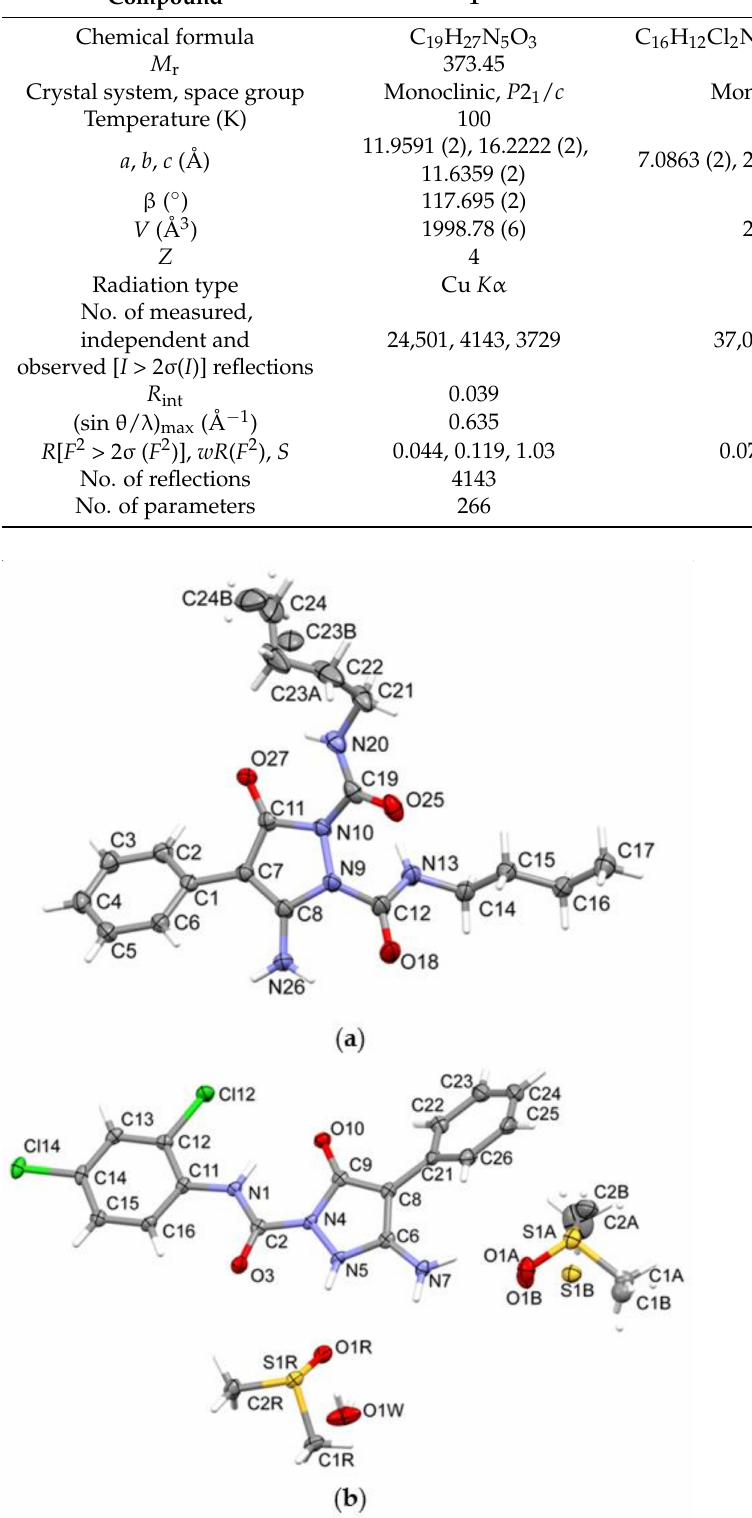
Figure 1. The molecular structure and atom-numbering schemes for: compound 1 —figure ( a ), and compound 2 — figure ( b ), with displacement ellipsoids drawn at the 50% probability